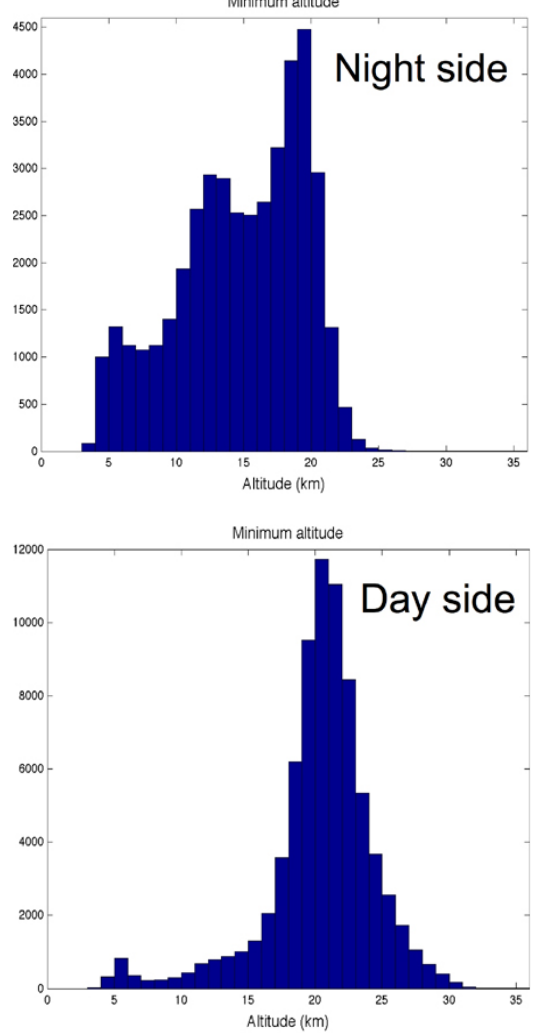
Fig. 10. The distribution of the termination altitudes during all the occultations of 2004. Top: dark limb occultations only. Bottom: bright limb occultations only. In dark limb the average is